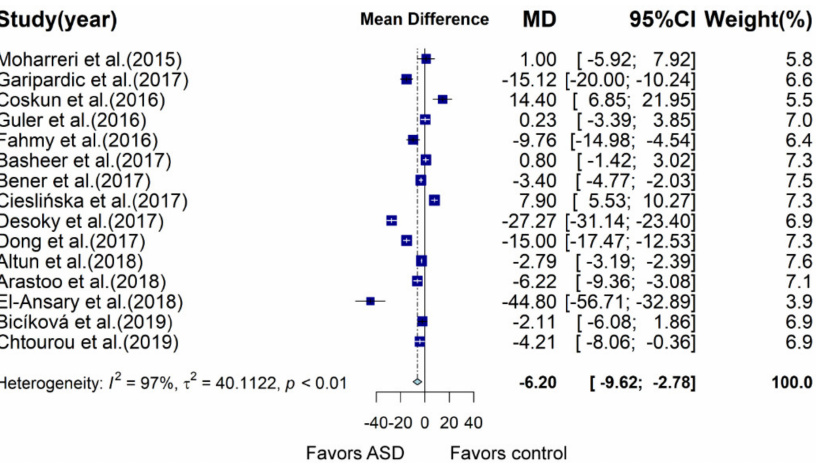
Figure 4. Forest plot of meta-analysis of 15 case–control studies based on vitamin D concentration, showing that children and adolescents with ASD have an average of 6.20 ng/mL lower vitamin D concentration than that of the control in studies conducted after May 2015, with 97% heterogeneity. MD, mean difference; CI, confidence interval.